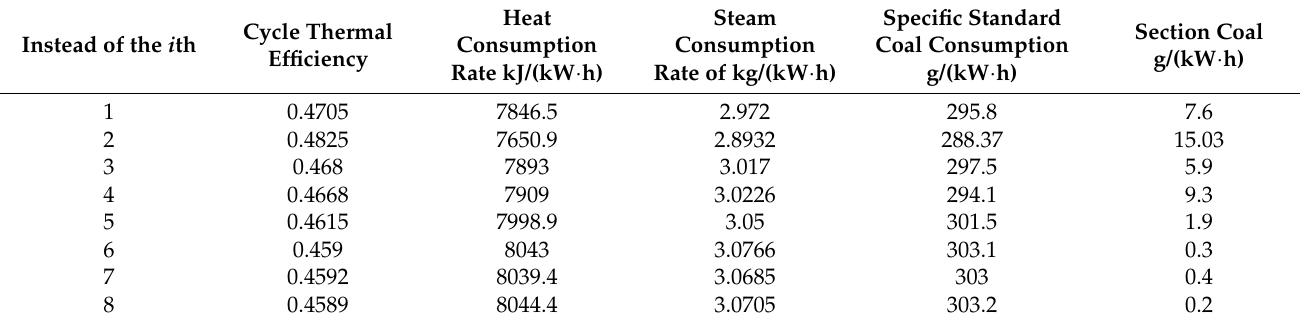
Table 1. 600 MW solar-aided power generation (SAPG) system thermal economy at full variable conditions.